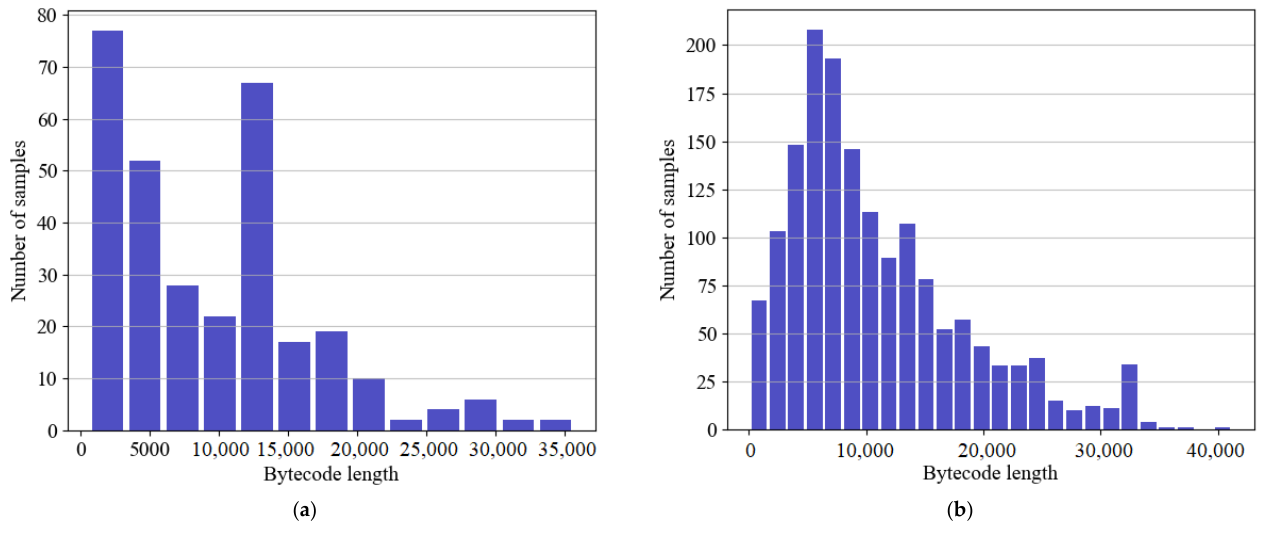
Figure 2. Distribution of contracts’ bytecodes size in our dataset in ( a ) abnormal contracts and ( b ) normal